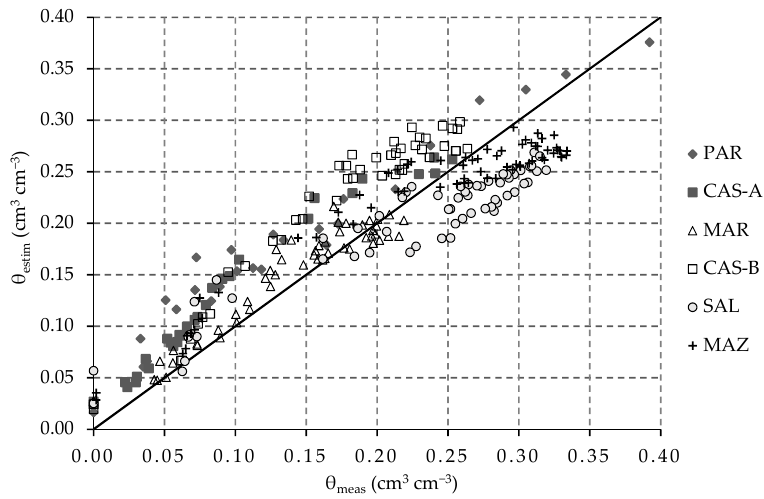
Figure 6. Relationship between volumetric soil water content measured in undisturbed monoliths and estimated with the proposed model. Table 6. Statistical parameters obtained by comparing the estimated soil water content, θ estim (cm 3 cm − 3 ) and the corresponding values measured on undisturbed monoliths.